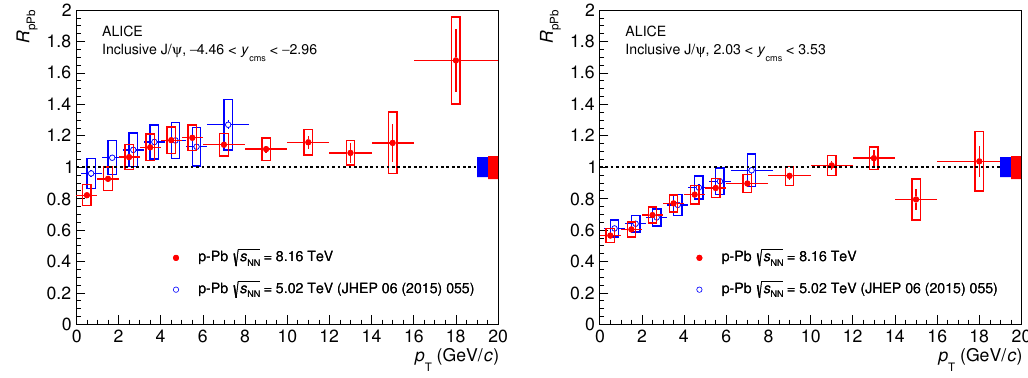
Figure 4 . The inclusive J/ nuclear modi(cid:12)cation factor in p{Pb and Pb{p collisions at 8 : 16 TeV, as a function of y cms . The horizontal bars correspond to the bin size. The vertical error bars represent the statistical uncertainties, the boxes around the points the uncorrelated systematic uncertainties. Correlated uncertainties are shown as a (cid:12)lled box around unity for each energy. The results are compared with those for p{Pb and Pb{p collisions at have been plotted at slightly shifted y cms values, for better visibility.